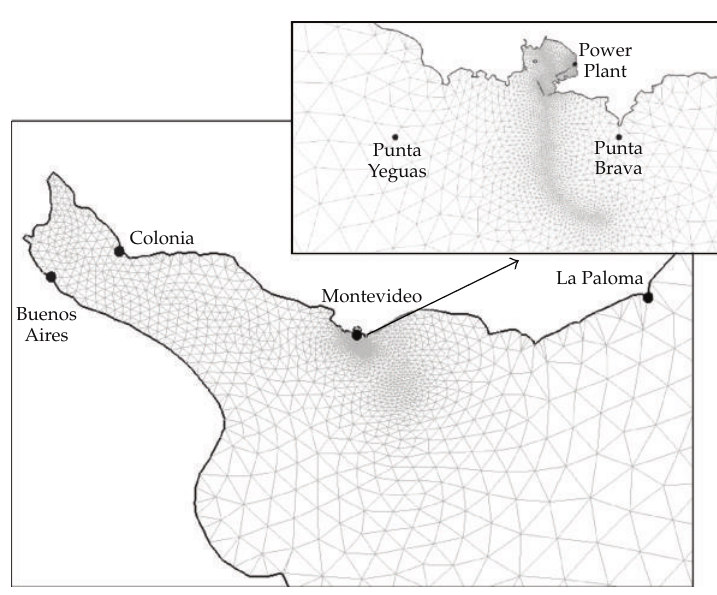
Figure 4: Location of the water surface elevation Rio de la Plata stations (cid:3) Buenos Aires, Colonia, Montev- ideo, and La Paloma (cid:4) , ADCP stations (cid:3) Punta Yeguas and Punta Brava (cid:4) , and temperature stations (cid:3) Punta Brava and Power Plant (cid:4)